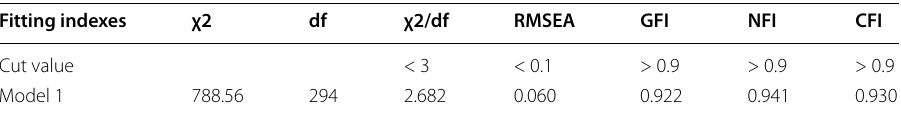
Table 3 Model fit indices (model